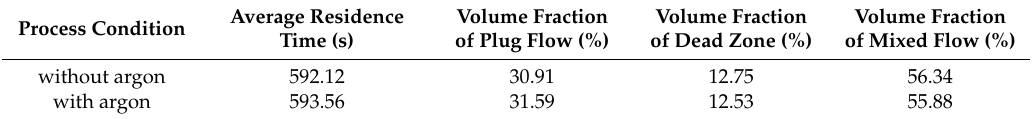
Table 4. Flow characteristics of the liquid steel in the tundish with and without blowing argon.